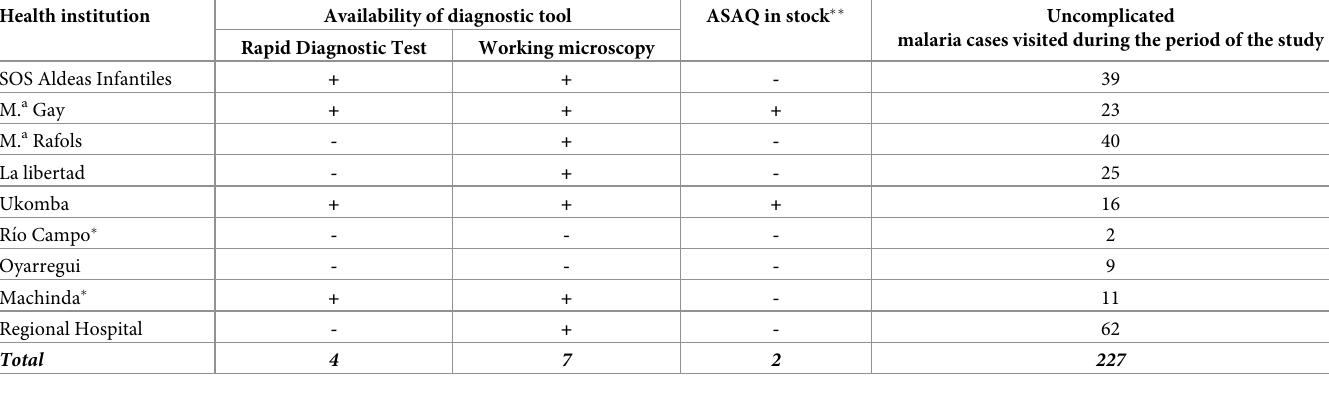
Table 4. Description of public healthcare facilities in the Bata